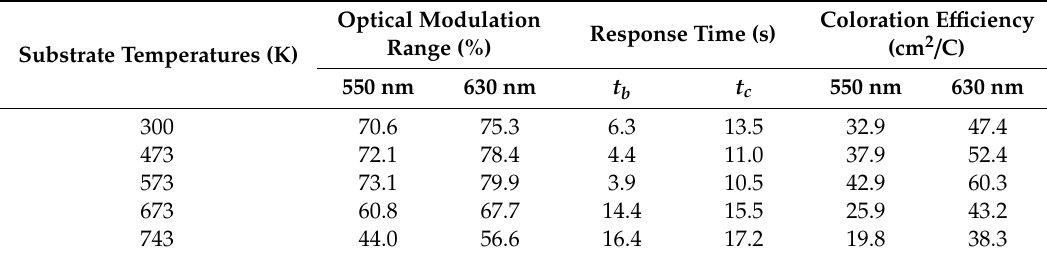
Figure 7. The WO 3 films deposited at different substrate temperatures: ( a ) chronoamperometry (CA) and ( b ) chronocoulometry (CC) curves. Electrochromic index various parameter of WO 3 films deposited at di ff erent substrate